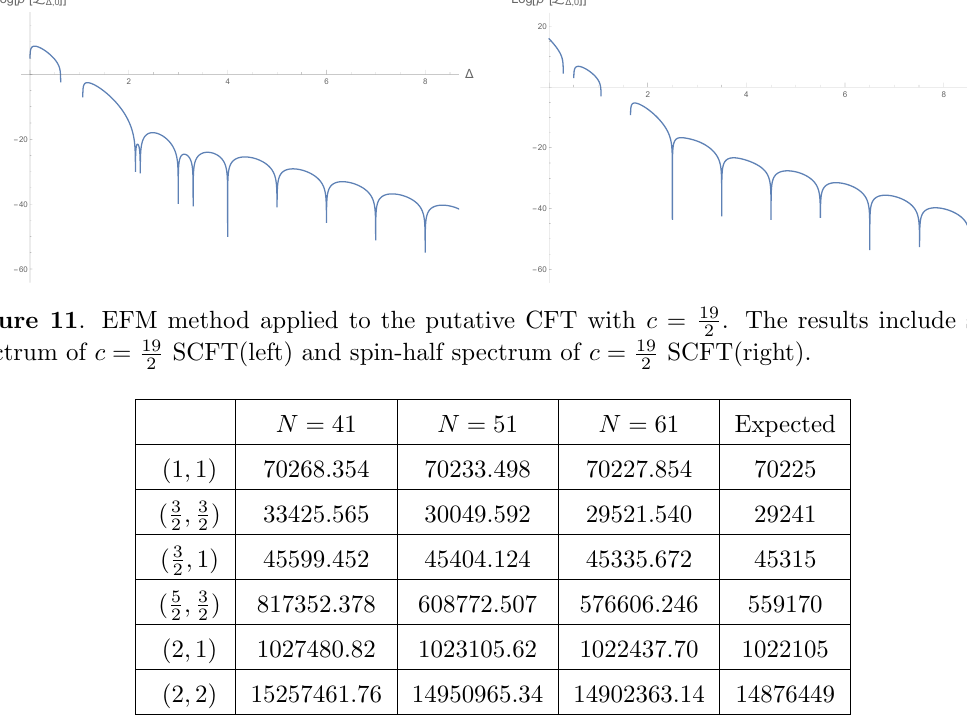
Table 6 . The maximum value of degeneracies for low-lying states in a putative N = (2 ; 2) CFT at c = 19 2